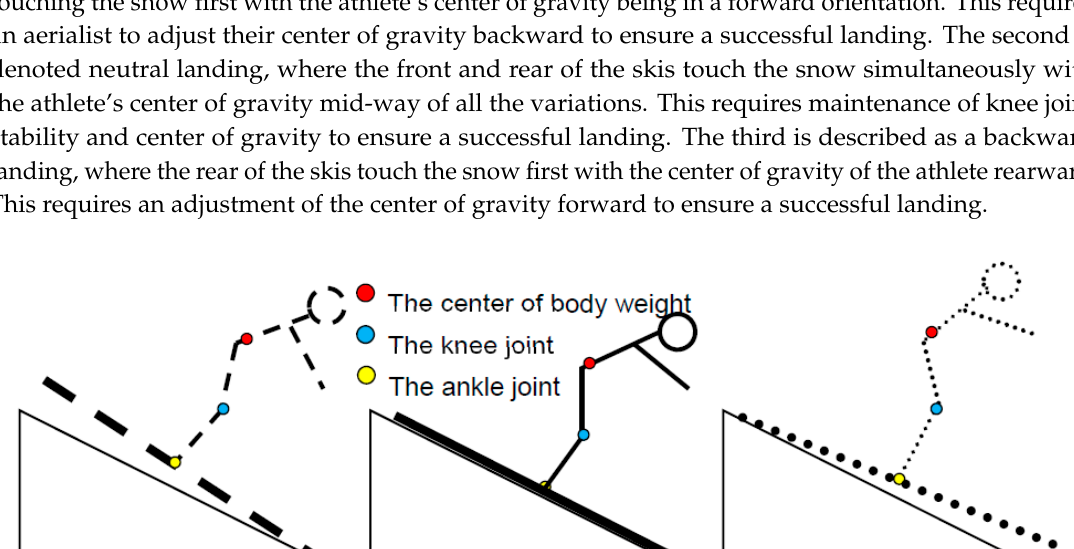
Figure 4. The three variations of successful landing.